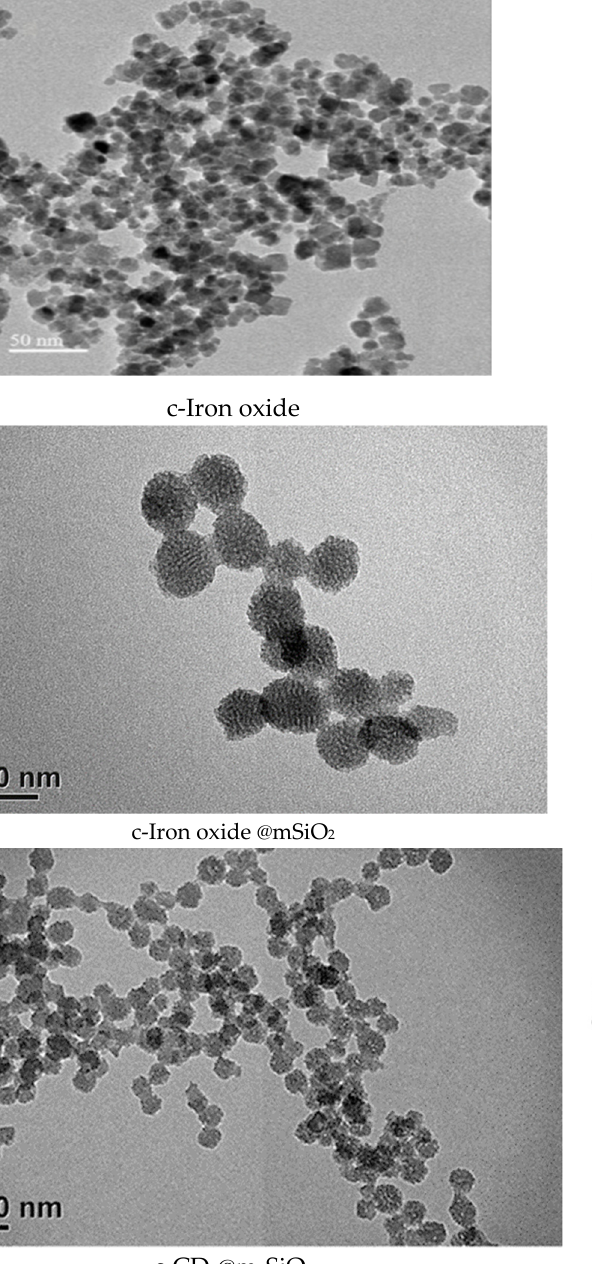
Figure 3. ( a ) Optimal emission spectra of the three types of CD s , ( b ) variations in the fluorescence intensity of CD b with each modification step, and ( c ) transmission electron microcopy images of iron oxide, iron oxide @mSiO 2 , and CDg@mSiO 2 . oxide, iron oxide @mSiO 2 , and CDg@mSiO 2